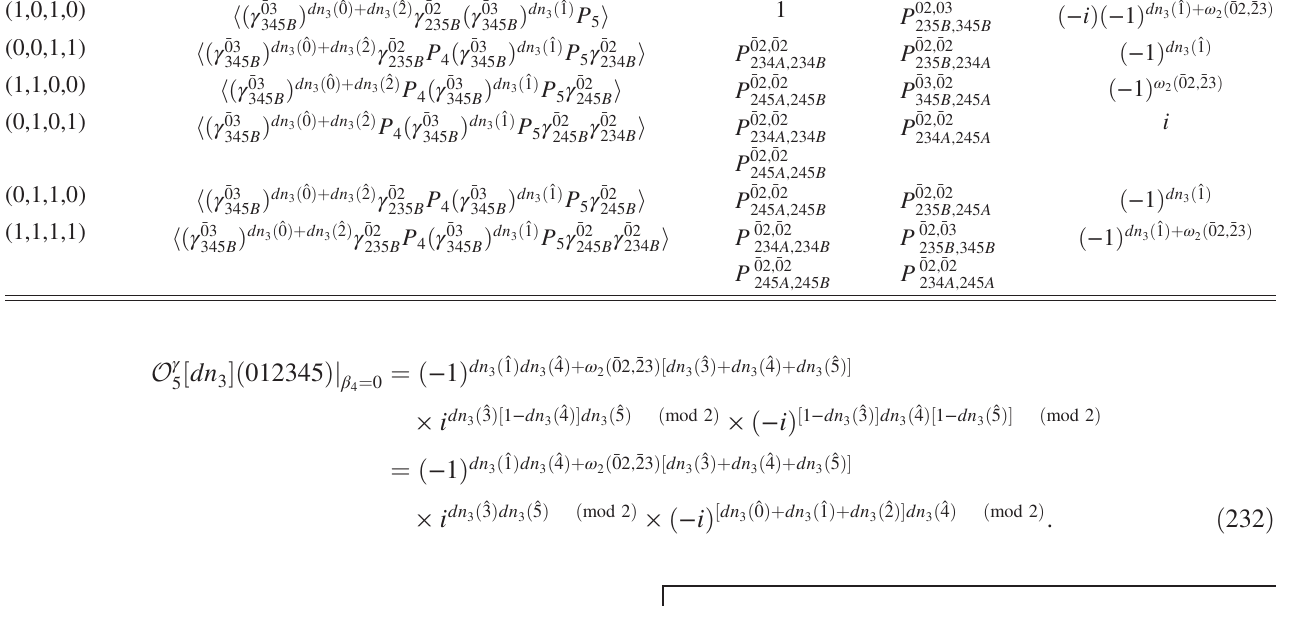
¯03 dn 3 ð ˆ 0 Þþ dn 3 ð ˆ 2 Þ P 4 ð γ ¯03 hð γ 345 B Þ